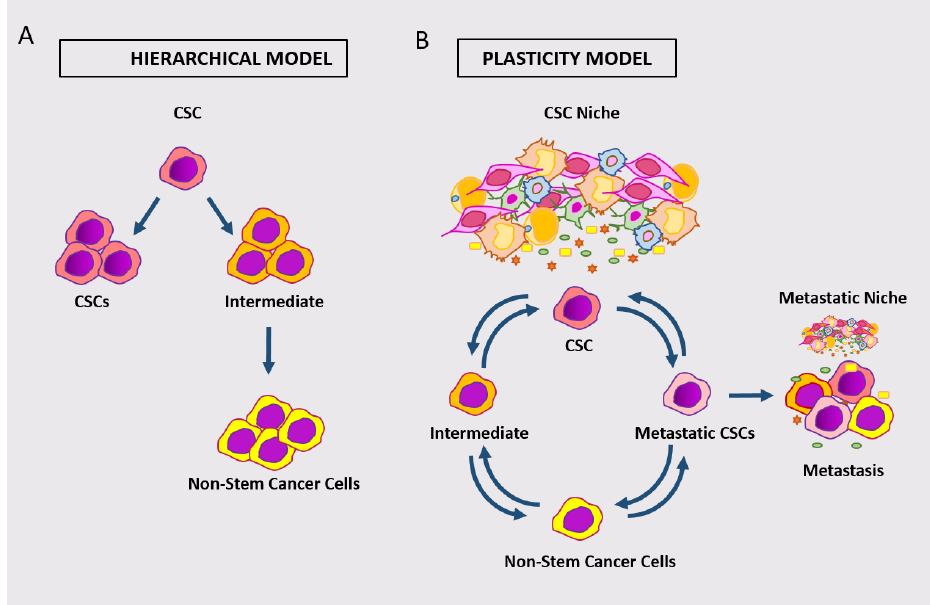
Figure 3. Schematic representation of the hierarchical model of cCSC ( A ) versus the model of plastic cCSC ( B ). According to the plastic model, different classes of cancer cells can dynamically take on stem cell phenotypes/functions.